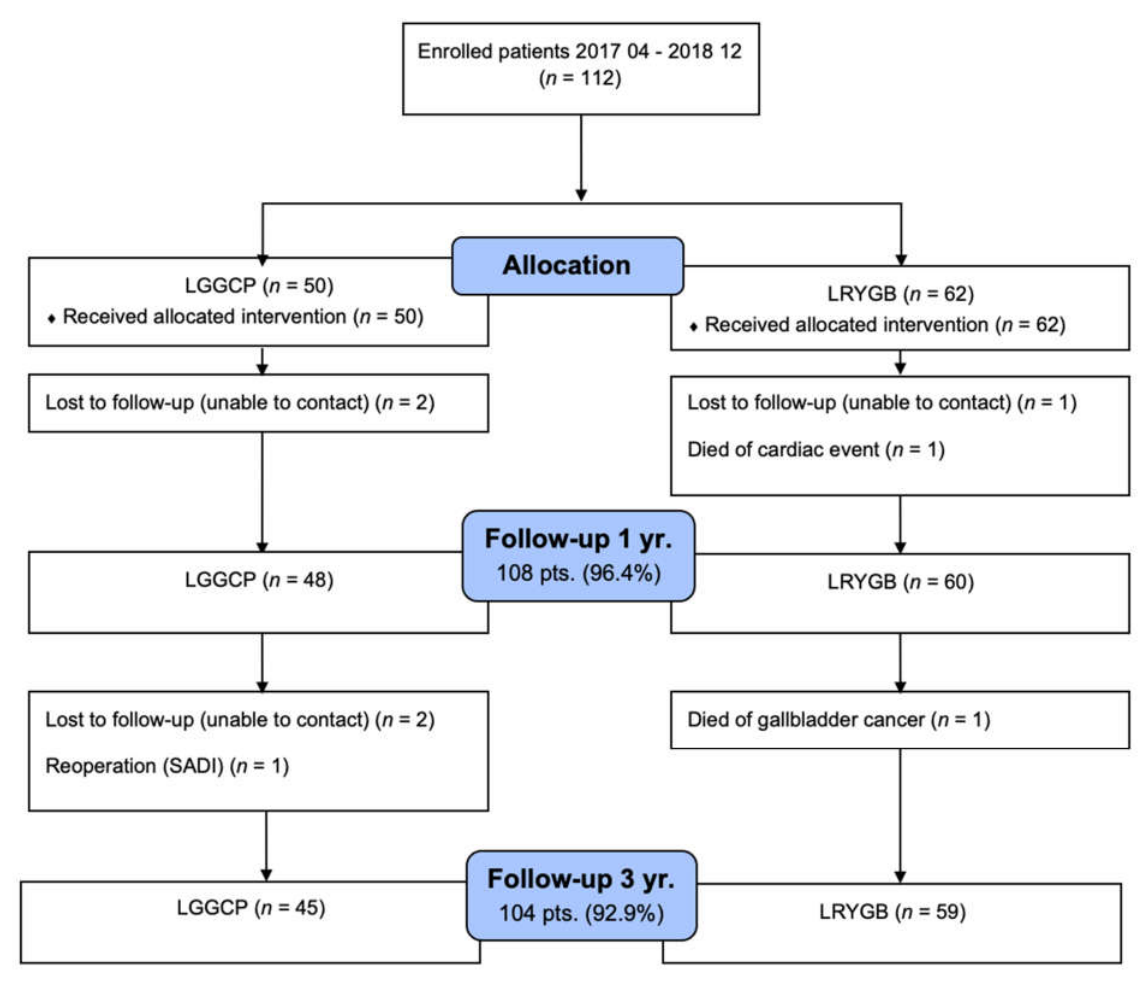
Figure 1. Postoperative patient follow-up.